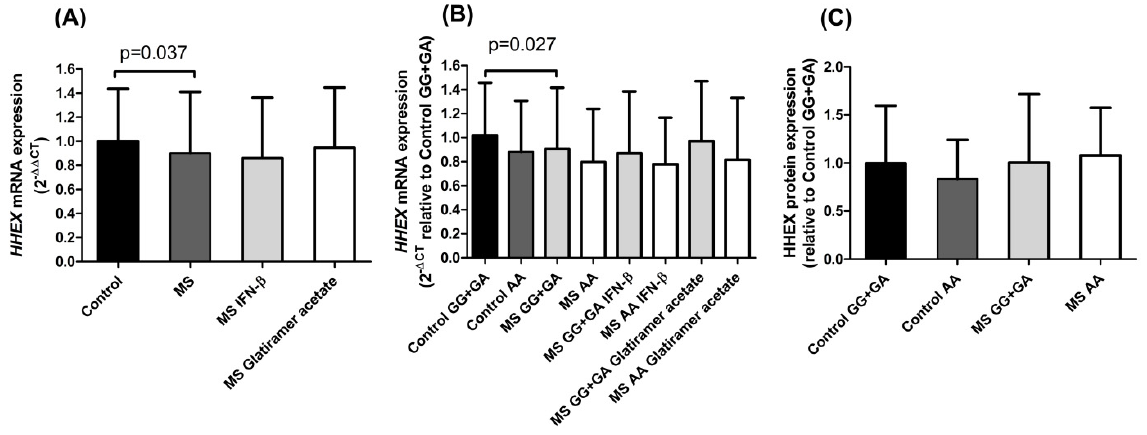
Figure 1. mRNA and protein expression of HHEX. ( A ) mRNA expression in controls, multiple sclerosis (MS) patients, and MS patients stratified by treatment. Controls: n = 117; MS patients: n = 154; MS patients treated with IFN- β : n = 94; MS patients treated with glatiramer acetate: n = 57. ( B ) HHEX mRNA expression in controls and MS patients stratified by rs7923837 genotype. Heterozygotes were grouped with major homozygotes due to similar expression levels. Control GG + GA: n = 101; minor allele homozygous controls AA: n = 16; MS GG + GA: n = 133; MS AA: n = 18; MS GG + GA treated with IFN- β : n = 85; MS AA treated with IFN- β : n = 9; MS GG + GA treated with glatiramer acetate: n = 48; MS AA treated with glatiramer acetate: n = 9. ( C ) Expression of HHEX protein analyzed by Western blot, stratified by rs7923837 genotype. Control GG + GA: n = 24; Control AA: n = 9; MS GG + GA: n = 36; MS AA: n = 13. Mean and standard deviation are presented in all panels.